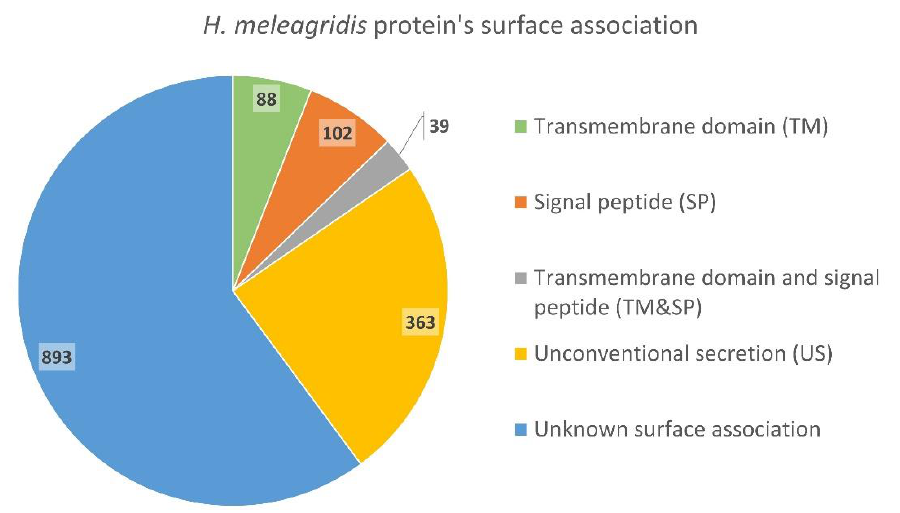
Figure 3. In silico prediction of surface and membrane association for H. meleagridis proteins identified by surface biotinylation.